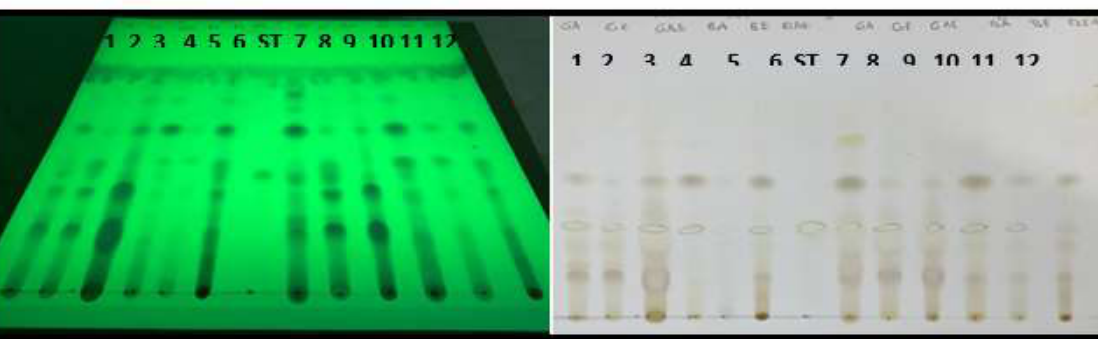
Figure 5. TLC chromatogram of ethyl acetate fractions of green and black tea, ST: epicatechin standard, 1: MGTA, 2: MGTE, 3: MGTAE, 4: MBTA, 5: MBTE, 6: MBTAE, 7: DGTA, 8: DGTE, 9: DGTAE, 10: DBTA, 11: DBTE, 12: DBTAE, using S2 as a solvent system.